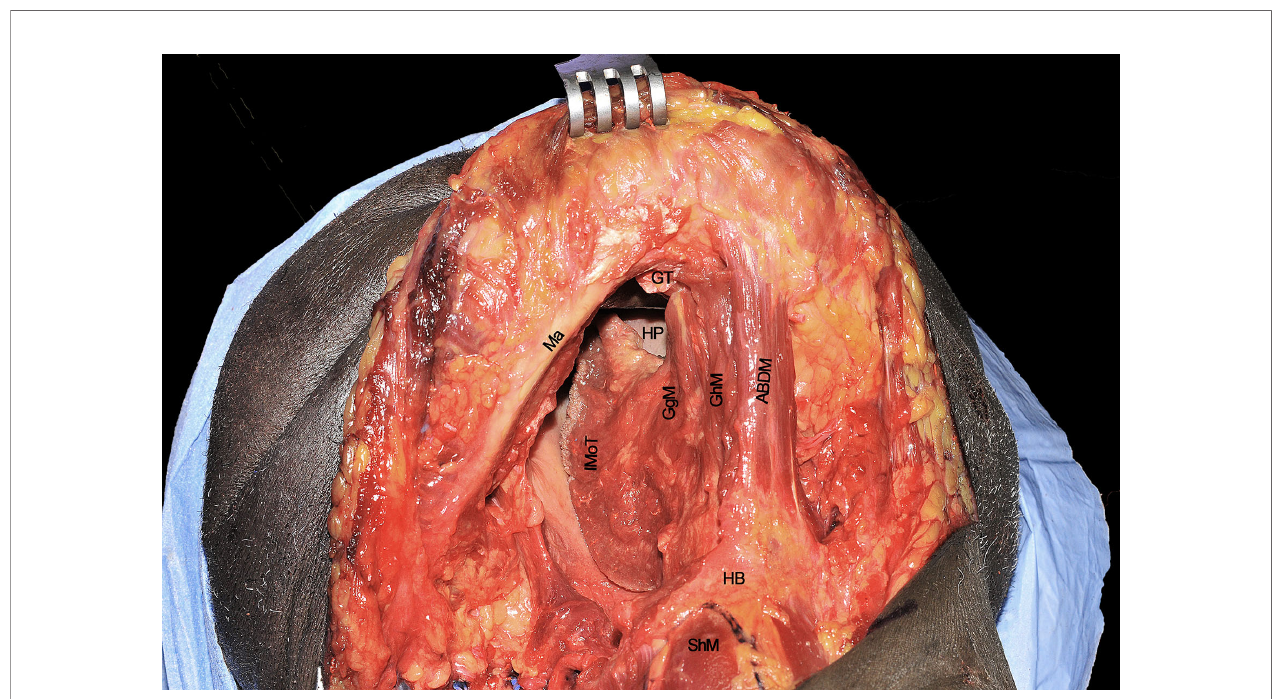
FIGURE 13 | ABDM, anterior belly of digastric muscle; HB, hyoid bone; GgM, genioglossus muscle; GhM, geniohyoid muscle; GT, genial tubercle; HP, hard palate; IMoT, intrinsic muscle of tongue; Ma, mandible; ShM, sternohyoid muscle.